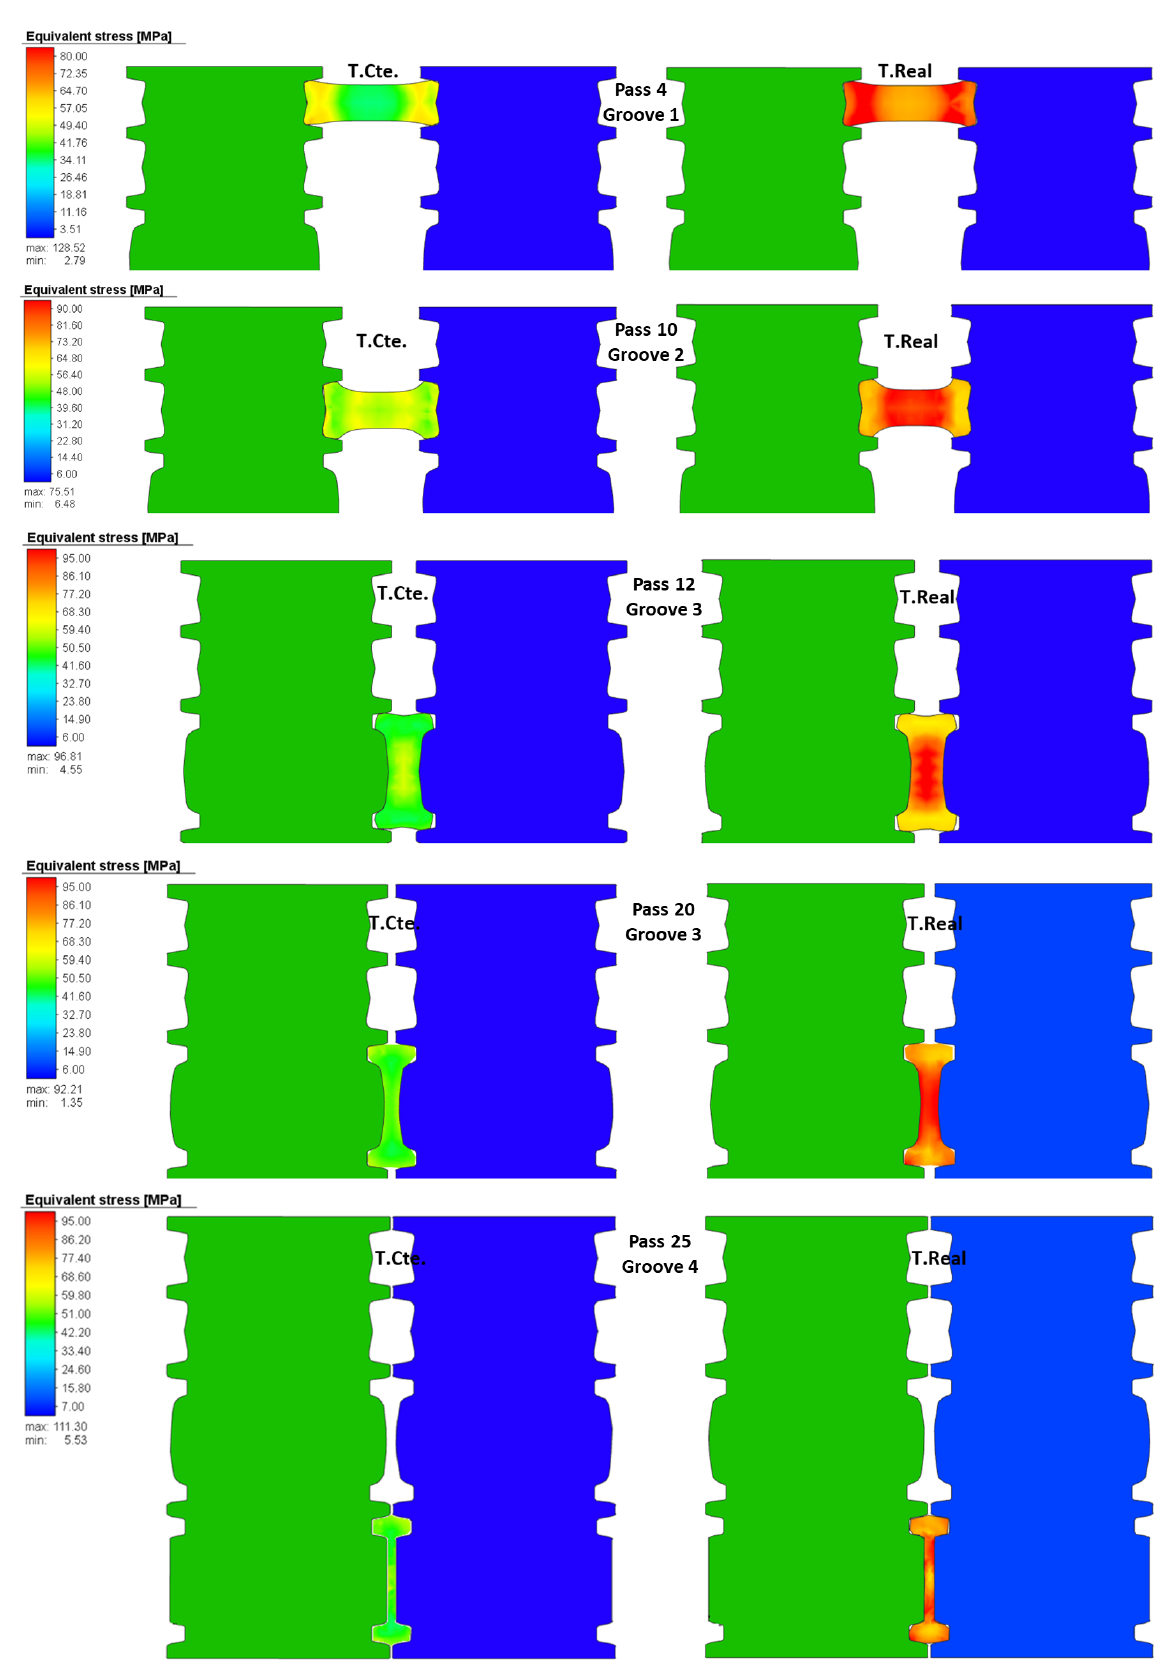
Figure 8. Distribution of effective stress in the middle of the beam during rolling of selected passes for simulations at constant and real